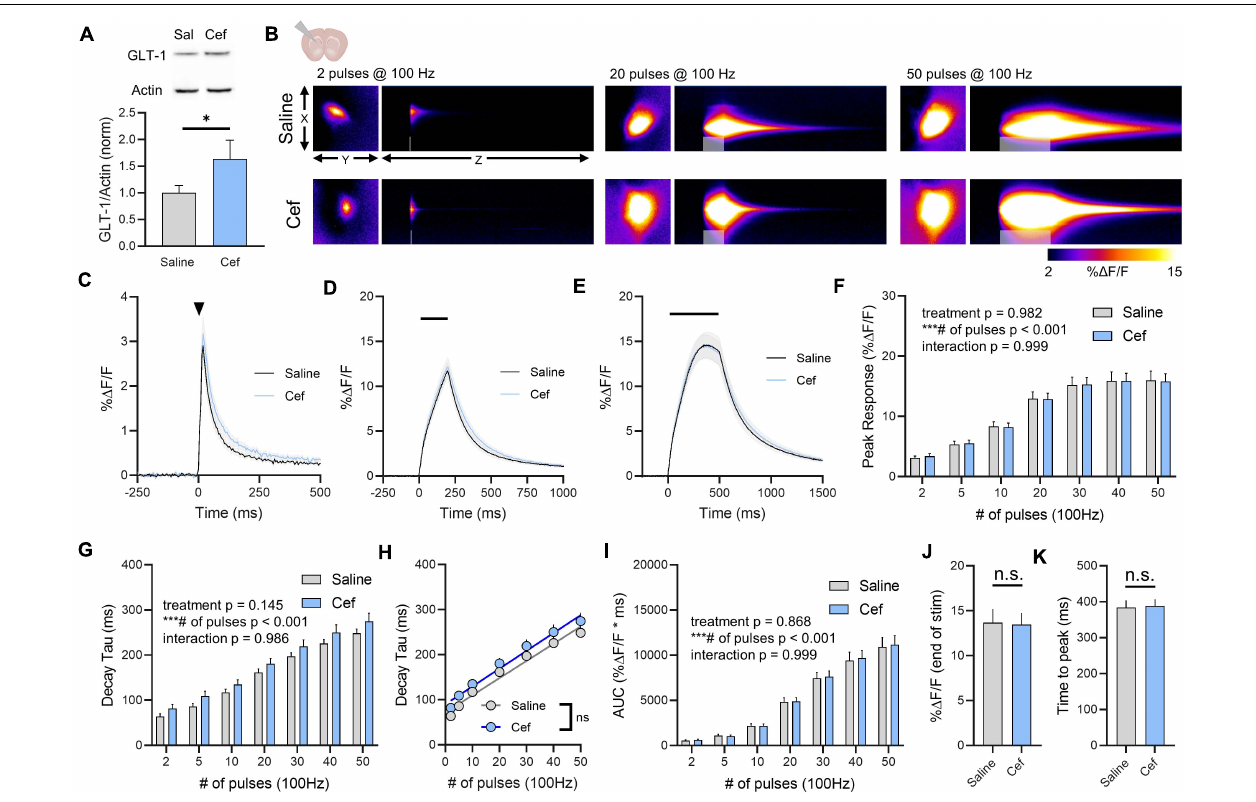
FIGURE 3 | The effect of ceftriaxone on glutamate dynamics in the striatum. (A) GLT-1 expression in striatal tissue from saline and ceftriaxone (Cef)-treated mice. (B) Representative images depicting the iGluSnFR response evoked by 2 (left), 20 (middle) and 50 (right) pulses of electrical stimulation at 100 Hz in saline- (top) and Cef-treated (bottom) mice. X–Y images (2048 × 2048 µ m) depict the maximal projection image of the iGluSnFR response while the X–Z image (2048 µ m vertically x 1945 ms horizontally) depicts the iGluSnFR response over time (z-axis). Gray shading indicates the onset and duration of electrical stimulation at 100 Hz. (C–E) Mean ( ± S.E.M in gray) iGluSnFR responses to 2 (C) , 20 (D) , and 50 (E) pulses at 100 Hz in saline- and Cef-treated mice. Electrical stimulation is denoted by the arrowhead in (C) and the horizontal lines in (D) and (E) . (F) Mean ( ± S.E.M) iGluSnFR response peaks. (G) Mean ( ± S.E.M) iGluSnFR decay tau values. (H) Linear regression to assess the magnitude of the activity-dependent increase in iGluSnFR decay tau. (I) Mean ( ± S.E.M) iGluSnFR area under the curve (AUC). (J) Mean ( ± S.E.M) of the iGluSnFR response size (% (cid:49) F / F ) at the termination of the 50-pulse stimulation paradigm (50 pulses at 100 Hz). (K) Mean ( ± S.E.M) of the time required for the iGluSnFR response to reach a peak during the 50-pulse stimulation paradigm. ∗ p < 0.05, ∗∗∗ p < 0.001. n.s. not significant. Brain slice schematic in (B) was created using